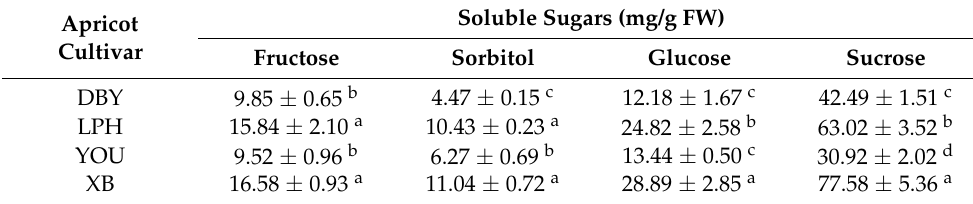
Table 2. The composition and content of soluble sugars in four different apricot cultivars. Apricot Cultivar